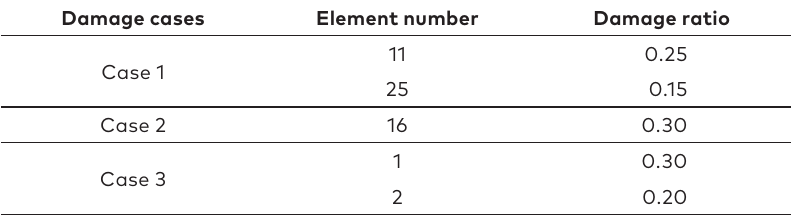
Table 4. Different damage cases for a 31-element truss